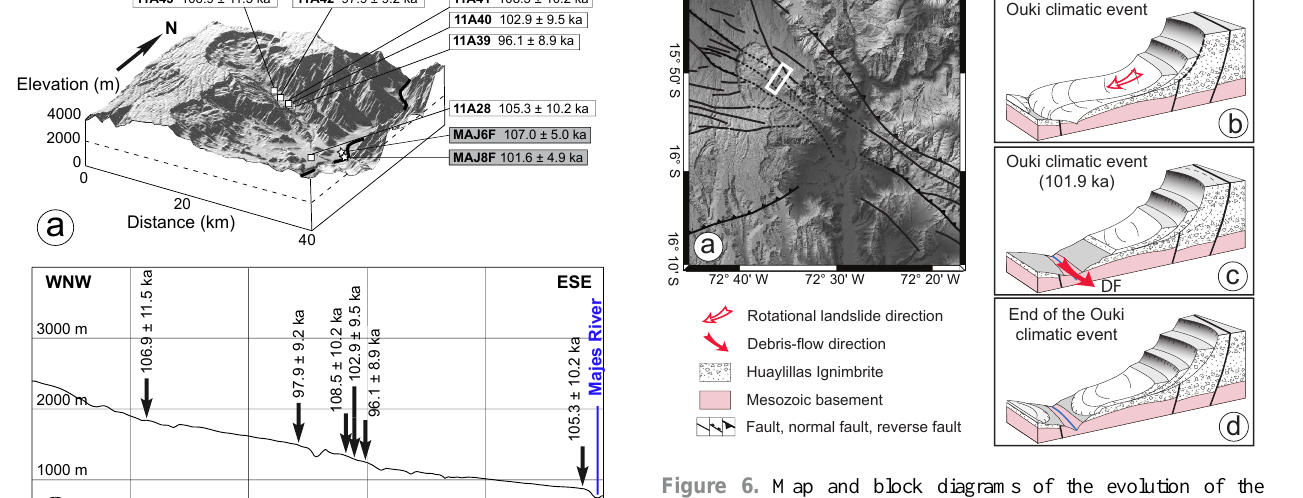
Figure 6. Map and block diagrams of the evolution of the Chuquibamba landslide. (a) SRTM numerical elevation model, the white rectangle localizes the block diagrams. (b) Block dia- gram showing rotational landslide initiation on the flank of the Chuquibamba Valley during the Ouki wet event. The landslide en- larges the valley and accumulates material at the bottom. (c) The accumulated materials are remobilized by debris flows during the wetter phases. (d) This remobilization allows new rotational land- slides that enlarge the amphitheater-shaped